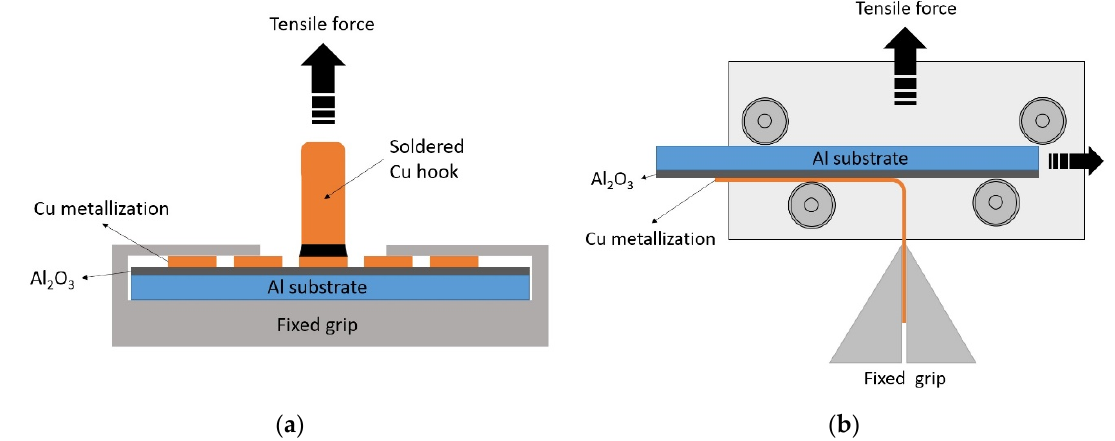
Figure 1. ( а ) Scheme of pull-off adhesion measurements. ( b ) Scheme of peel test adhesion